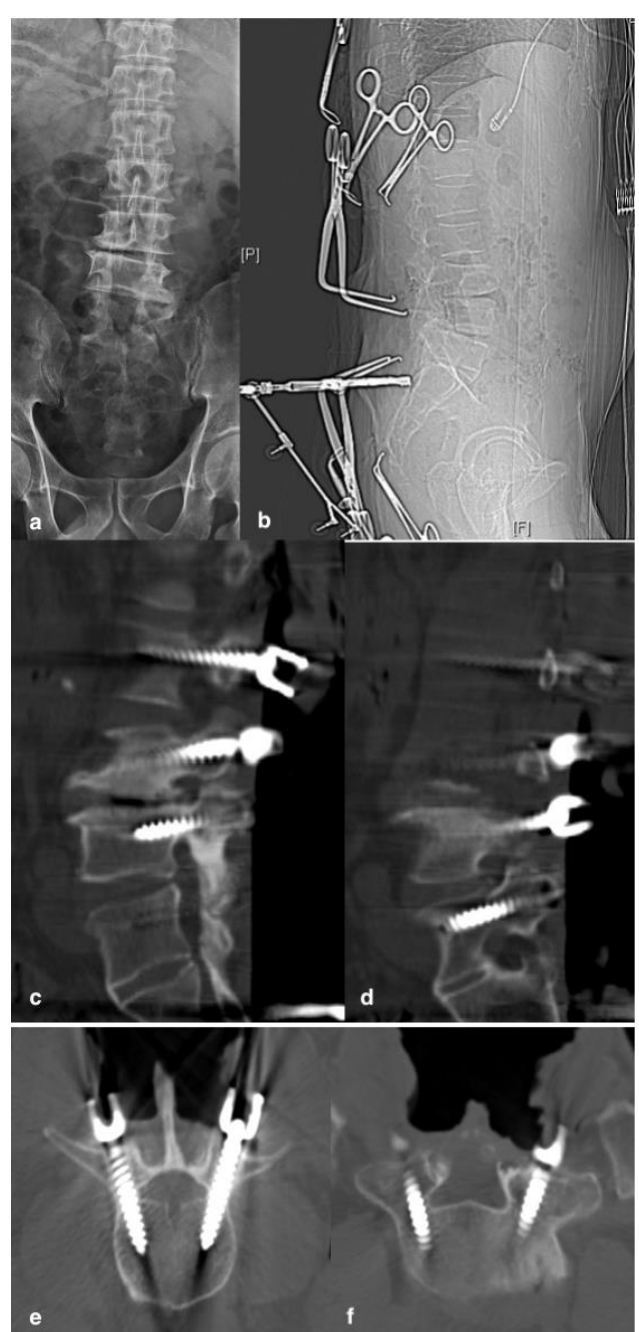
Figure 2. A 55-year-old male patient with post-laminectomy instability and spinal stenosis; X-ray ( a ) showed previous laminectomy of L4, L5 and partial L3. This patient underwent revision spinal